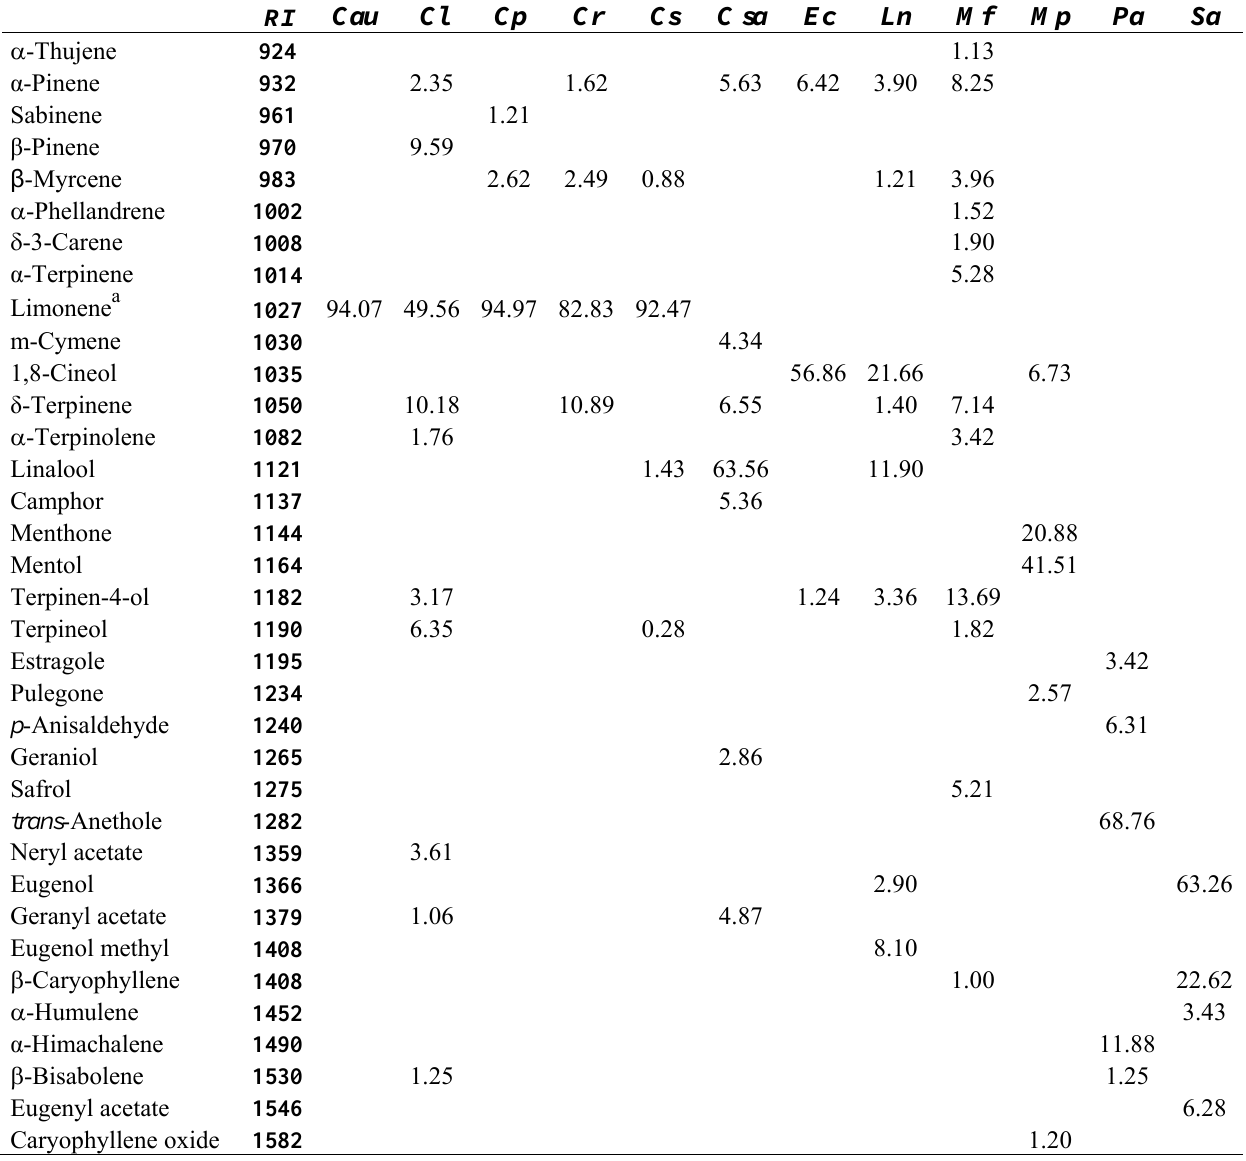
Table 1. Components (percent) of the essential oil